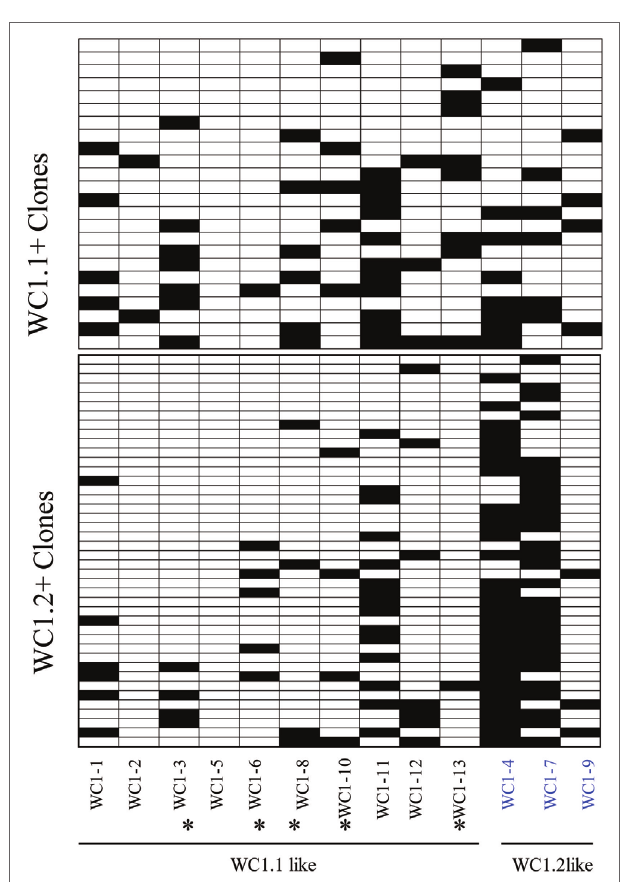
FigUre 5 | WC1 gene transcripts associated with individual WC1.1 + or WC1.2 + clones. The various combinations of WC1 gene transcripts are shown for clones derived by flow cytometrically sorted cell subpopulations in a heat map. * = WC1 gene products that bind Leptospira .